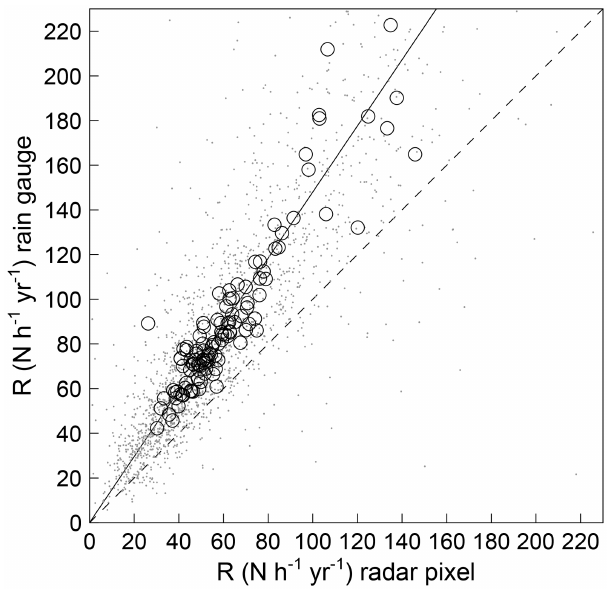
Figure 4. Annual erosivity R y (grey points) and multi-annual mean erosivity R (black circles) derived from radar pixel and rain gauge data for 115 point–pixel pairs and 16 years. The difference in slope between the solid line and unity (dashed line) is due to the spatial scale and method